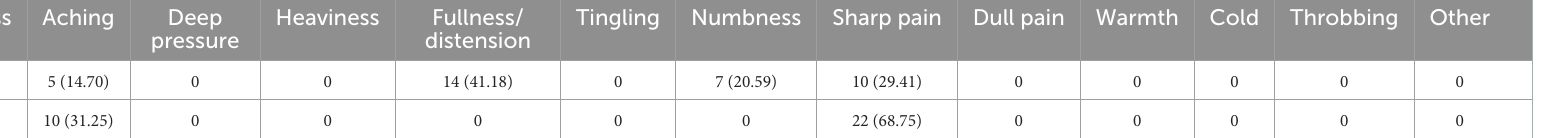
TABLE 9 Proportion of each participants-reported needle sensation recorded by MASS (participants = 66). MASS Soreness Aching Deep Heaviness Fullness/ Tingling Numbness Sharp pain Dull pain Warmth Cold Throbbing pressure distension